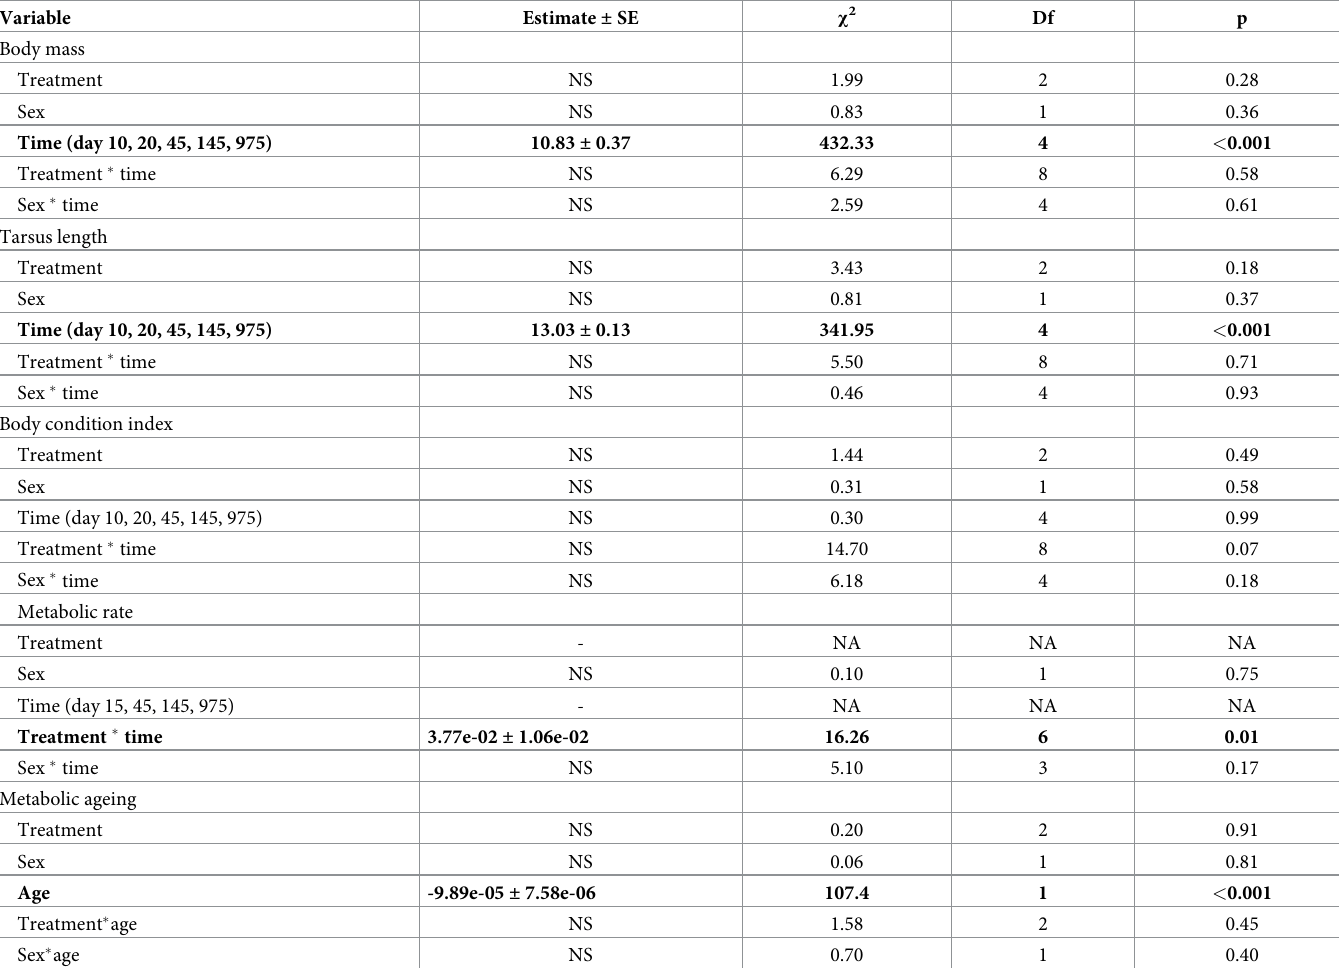
Table 3. Results of linear mixed effects models on body mass, tarsus length, body conditions index and metabolic